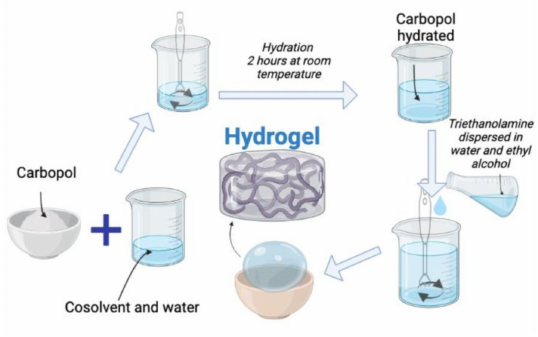
Figure 15. Hydrogel’s preparation graphic